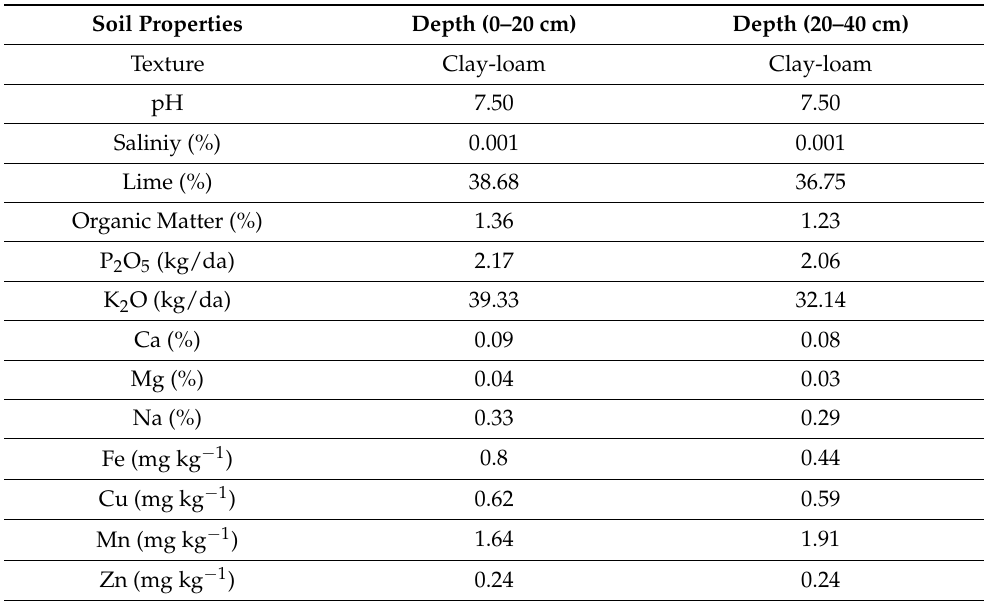
Table 1. Basic soil data of the experimental